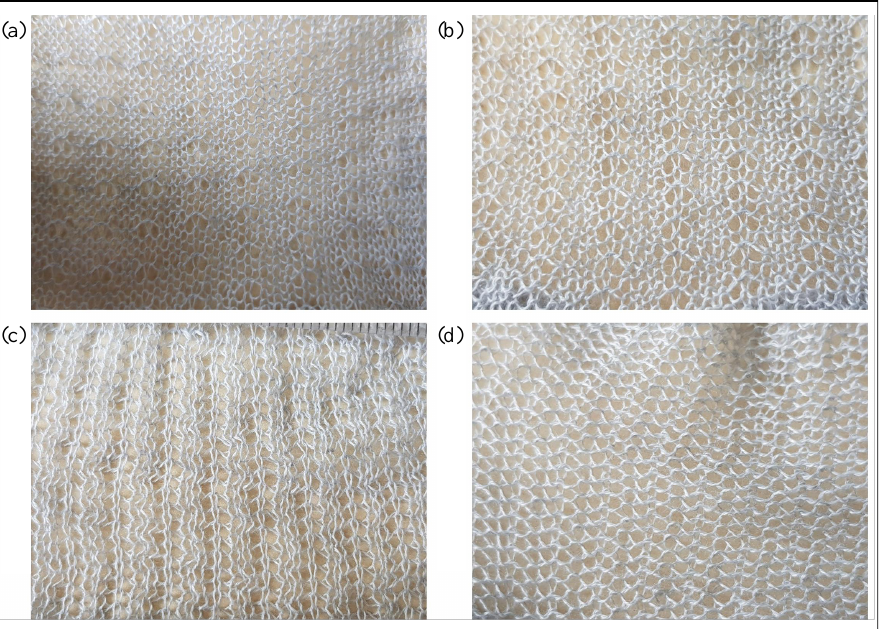
Figure 8. Knitted samples with tuck stitches. ( a ) 6.25% tuck stitches ( b ) 8.33% tuck stitches ( c ) 16.67% tuck stitches ( d ) 25% tuck